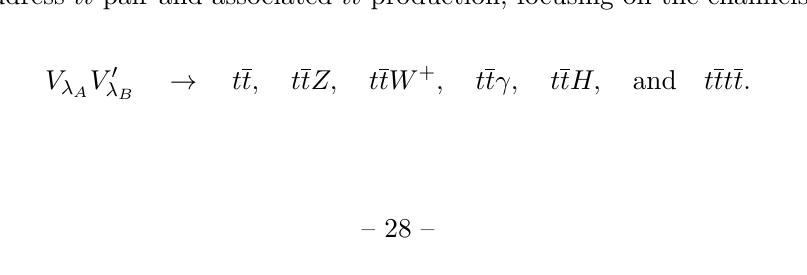
Table 4 . Fiducial cross sections with scale uncertainties for associated Higgs and multi-Higgs production in µ + µ − collisions through V EVA for polarization-summed and polarized initial states, at polarizations are defined in the hard-scattering frame. Phase space cuts are summarized in eq. (5.2). Also shown is the mg5amc syntax for modeling the process assuming the multi-particle definitions “ vxp=z,w+,a ” and “ vxm=z,w-,a .” The configuration (0 ,T ) implies a sum over both (0 ,T ) and ( T, 0) , and uses the syntax generate vxp{0} vxm{T} > ...; add process vxp{T} vxm{0} >